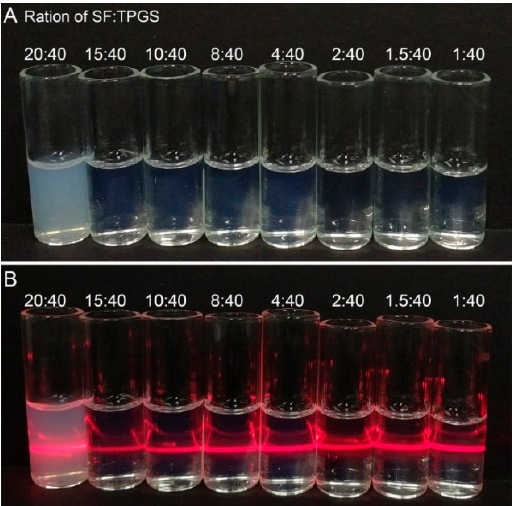
Figure A1. Photographs of ( A ) SF micelles with different mass ratios of SF:TPGS in glass bottles; ( B ) Tyndall effects of SF micelles solution.